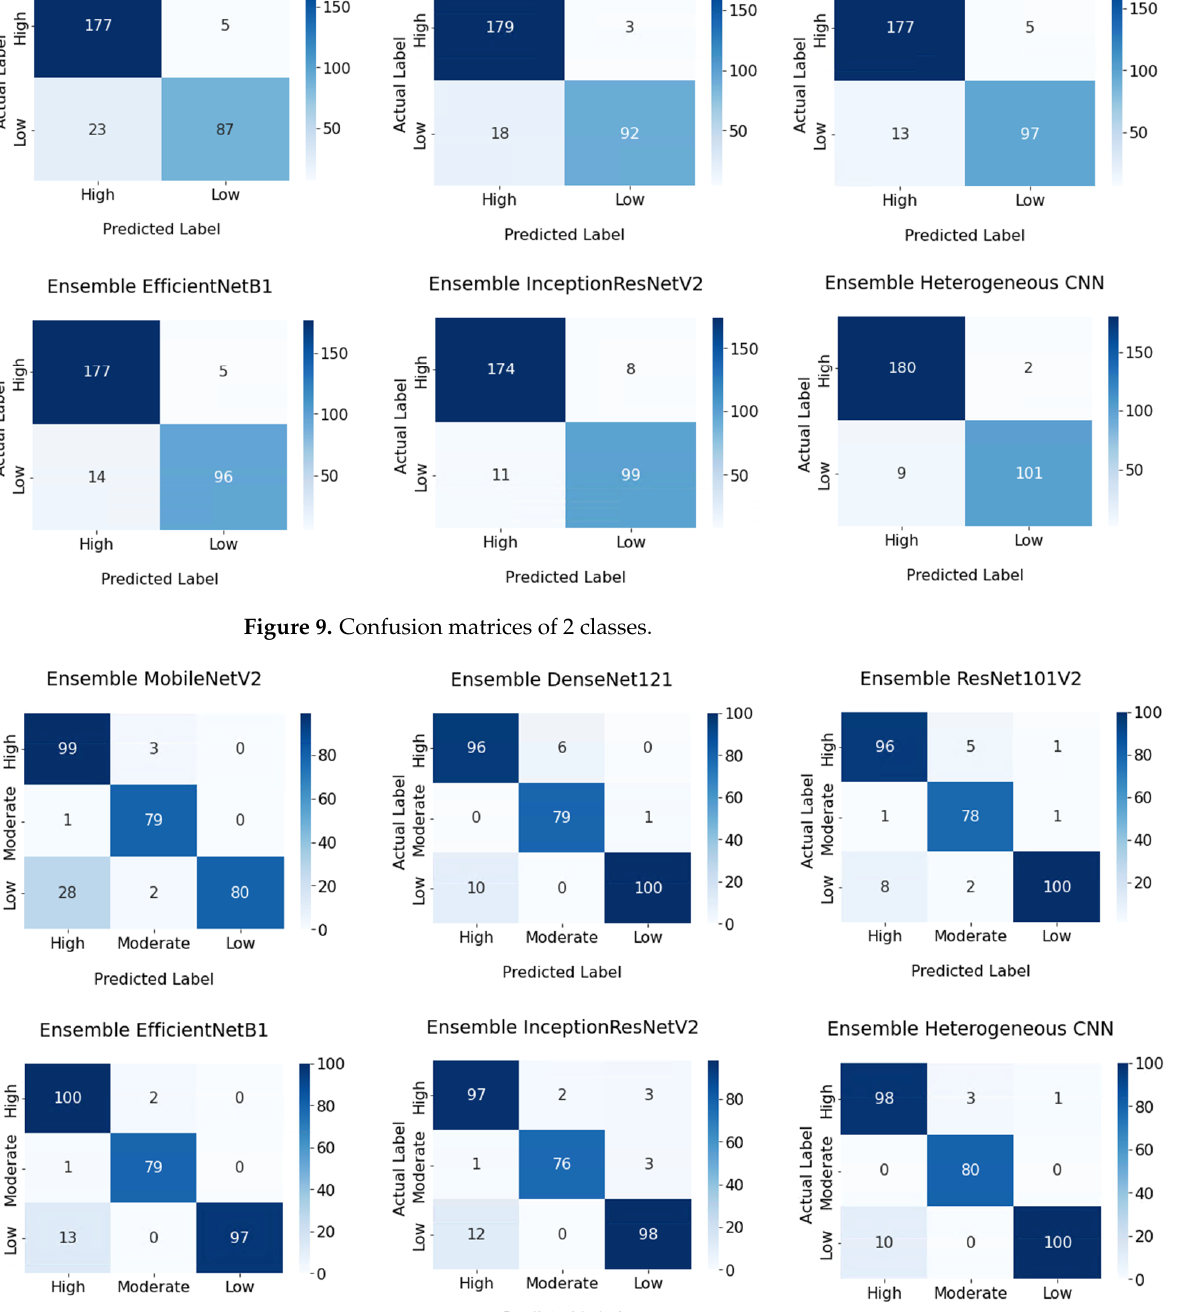
Figure 10. Confusion matrices of 3 classes.